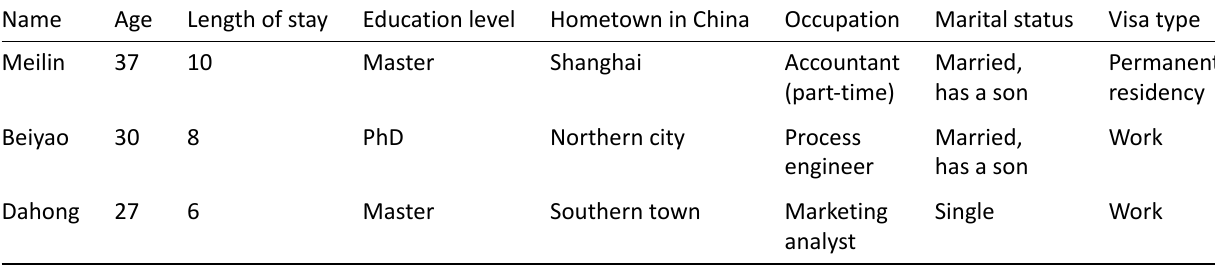
Table 2. Background of the three case study